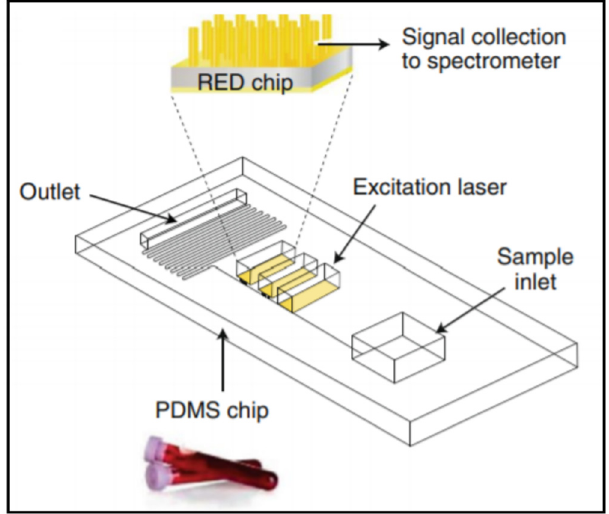
Figure 4. A SERS-based microfluidic device capable of a sample-in, results-out workflow from Rickard et al. Reprinted with permission from [48]. Springer Nature, 2020.